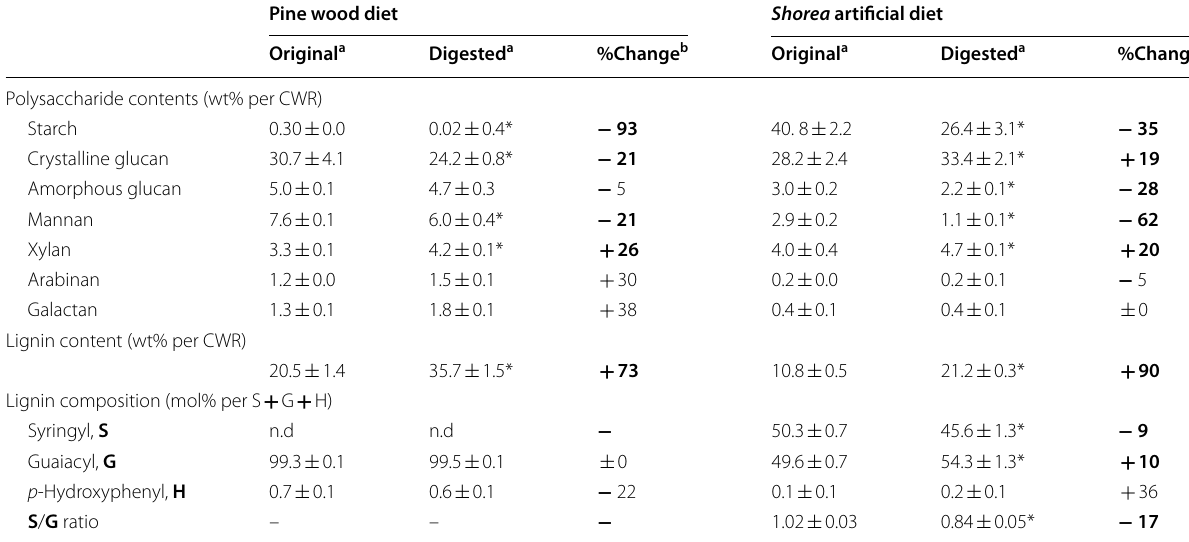
n.d., not detected. a Values are means standard deviation from triplicated runs. Asterisks (*) indicate significant differences between original and digested lignocellulose diets ± (Student’s t -test, p < 0.05). b Bold values indicate significant decrease or increase in digested compared with original lignocellulose